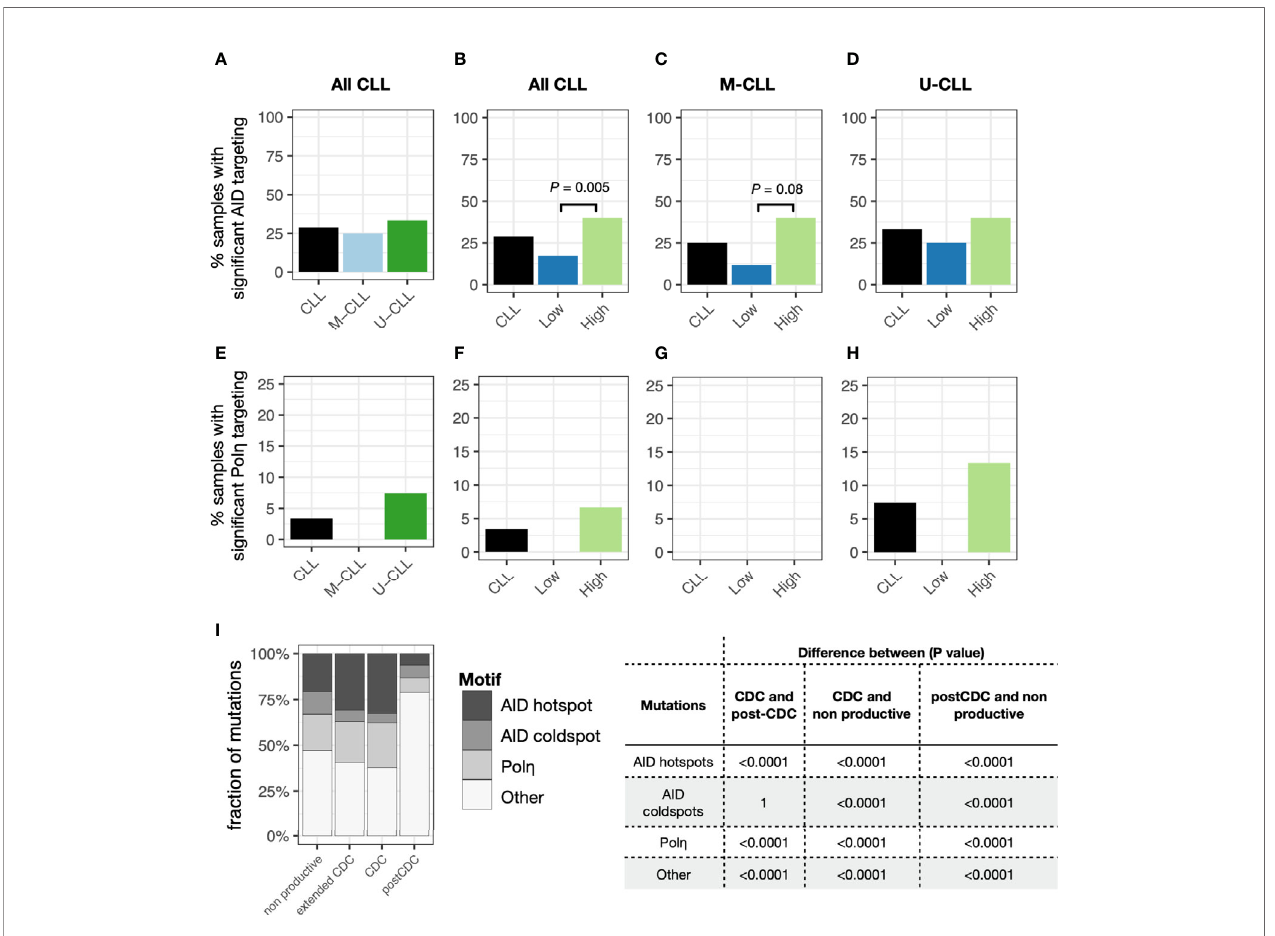
FIGURE 4 | Relative targeting of mutational mechanisms. (A – D) Percentage of samples exhibiting signi fi cant targeting to AID hot spots in subclones, based on IGHV-mutation status (A) , IGHV-mutation status + level of IGHV-D-J complexity for all CLL samples (B) or for only M-CLL (C) or only U-CLL cases (D) . (E – H) Percentage of samples exhibiting signi fi cant features of Pol h repair in subclones, based on IGHV-mutation status (E) , IGHV-mutation status + level of IGHV-D- J complexity for all CLL samples (F) or for only M-CLL (G) or only U-CLL cases (H) . (I) Fraction of post-CDC mutations attributable to the actions of AID at hot spots (red), AID at cold spots (green), of Pol h repair (blue), or other/unclear (purple). For each motif type (AID hotspot, AID coldspot, Pol h hotspot, all others), we calculated the fraction of mutations targeting the motif. Within each sample, this was done separately for the CDC, post-CDC, and non-productive sequences, giving a pair of fractions per sample. After calculating pairs for each sample, then CDC, post-CDC and non-productive sequences were compared across all samples using a paired t-test. Table to the right indicates the mean fractional differences of mutations between the CDC and the post-CDC settings in regard to mutations targeting the three motifs and not attributable to the any of the